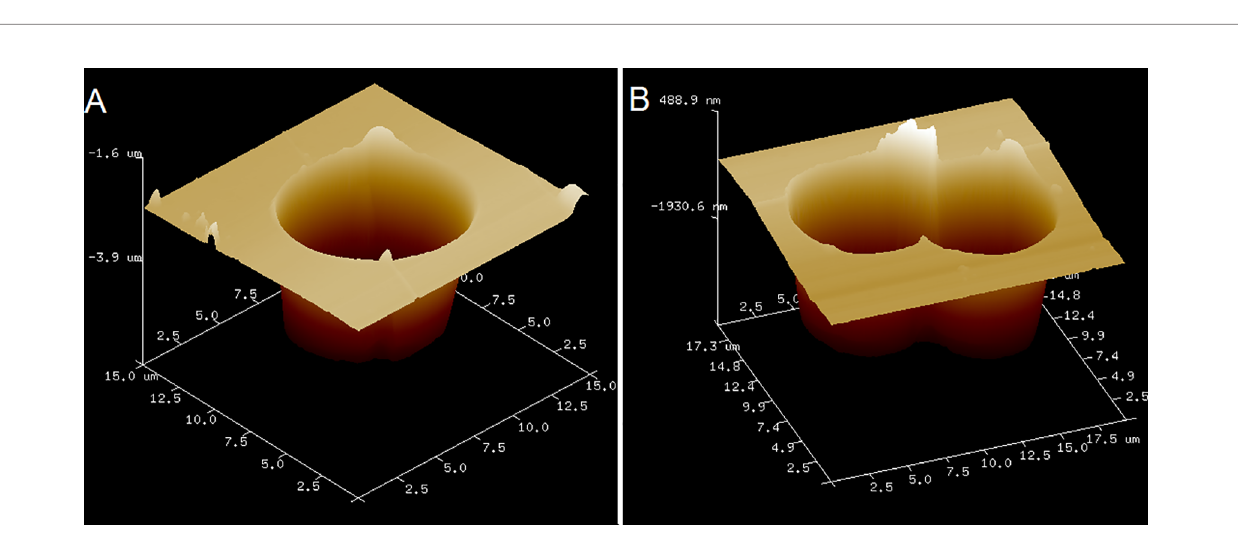
FIGURE 8 | Different types of “ slots ” in the 10-µm pore size polycarbonate membrane. (A) A single 10 m m hole. (B) Two 10 m m connected holes.